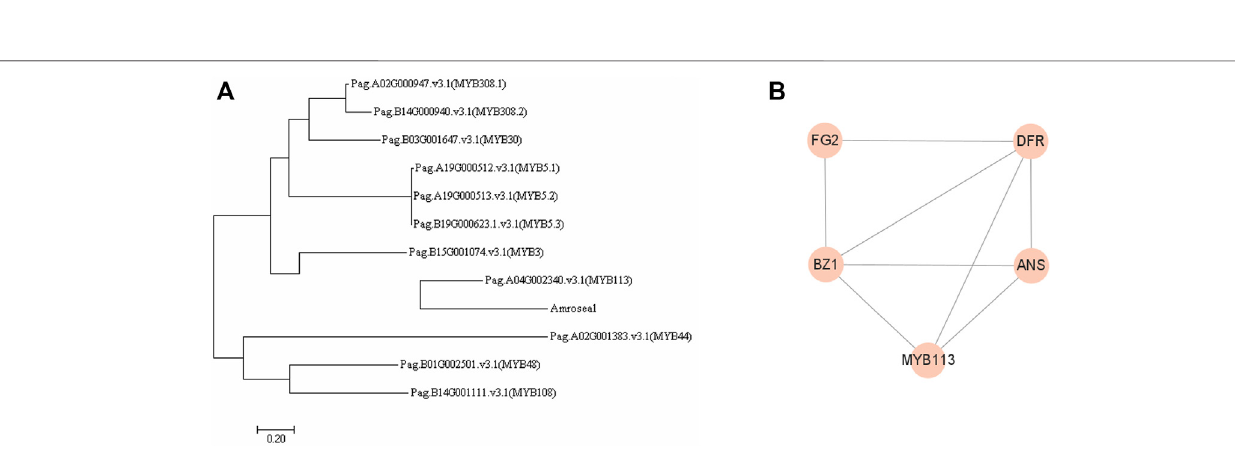
Frontiers in Bioengineering and Biotechnology |